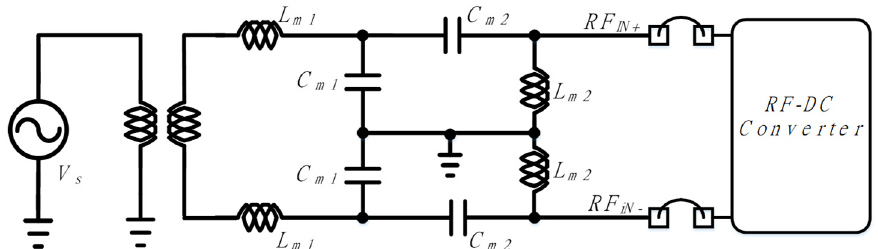
Figure 9. Schematic of the dual-band impedance-matching network.